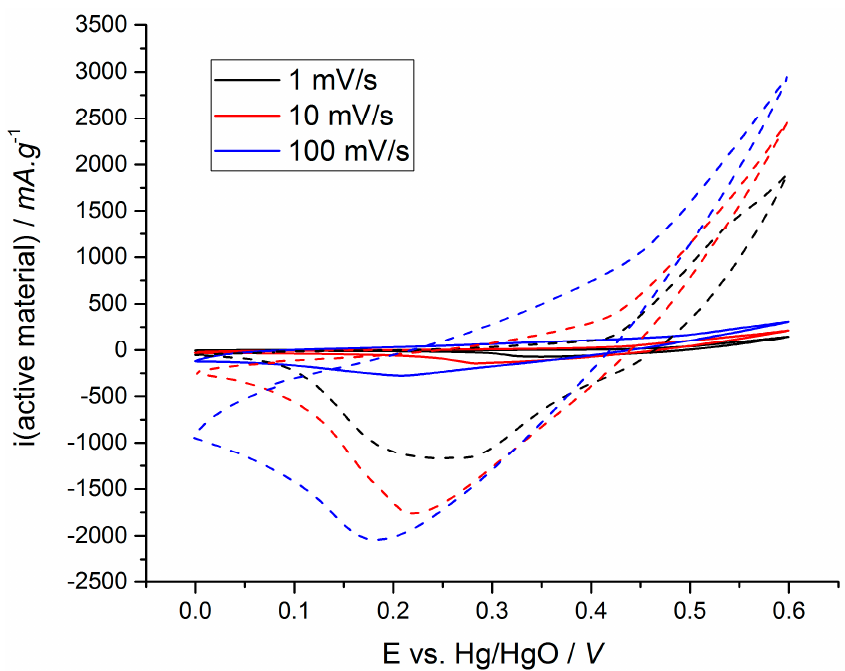
Figure 4. Cyclic voltammograms of Ni(OH) 2 sintered electrode (straight line) and Ni(OH) 2 :carbon black composite electrode (dash line) in 1 M KOH electrolyte at 1, 10 and 100 mV·s − 1 .